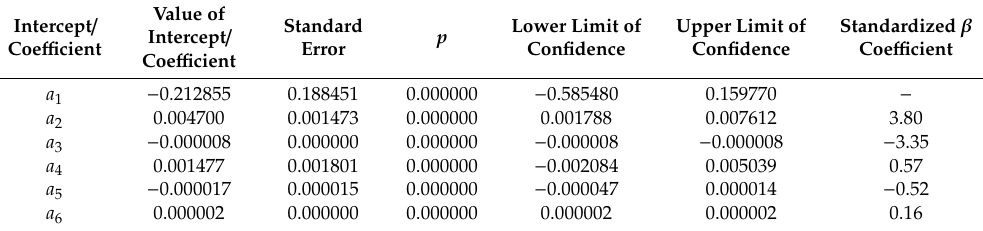
Table 9. Statistical evaluation of C content model of torrefied pruned biomass.